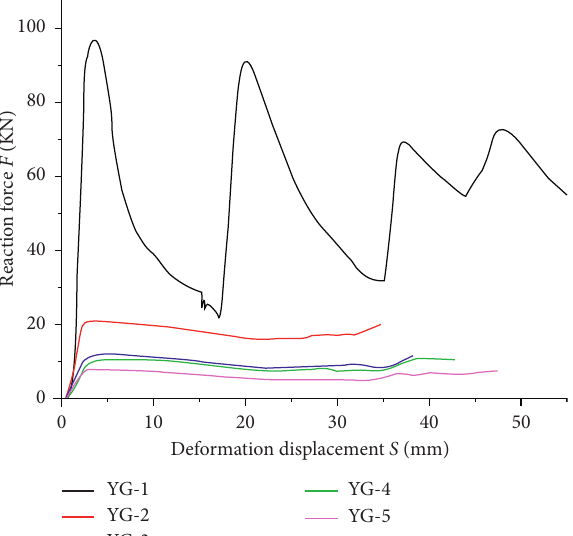
Figure 5: Support reaction force-deformation curve for simulation of crushing and buckling of thin-walled circular tube members with different